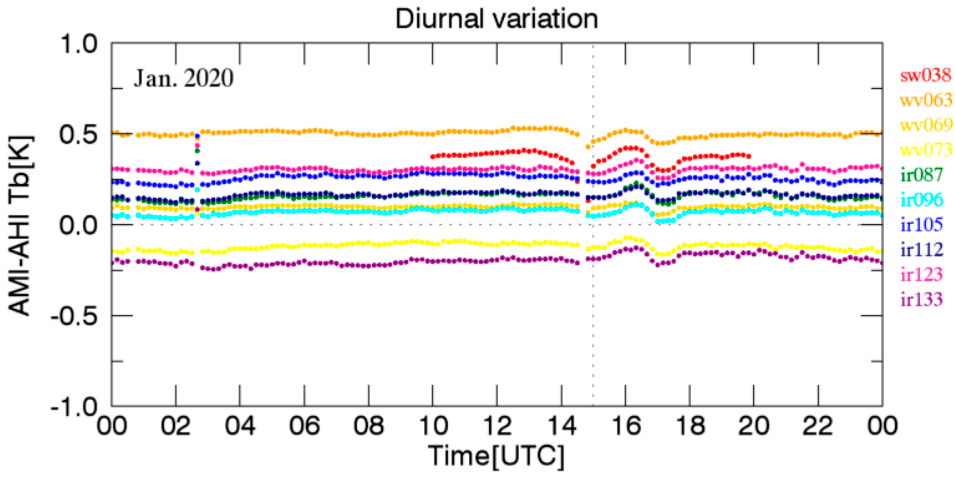
Figure 13. Diurnal variation of Δ TB (AMI-AHI) [K].